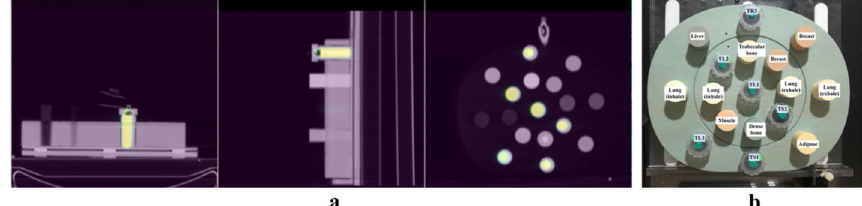
Fig. 3 a Axial, sagittal and coronal slices of static PET/CT image of the CIRS phantom with the six inserts filled with activity. b CIRS phantom with the inserts’